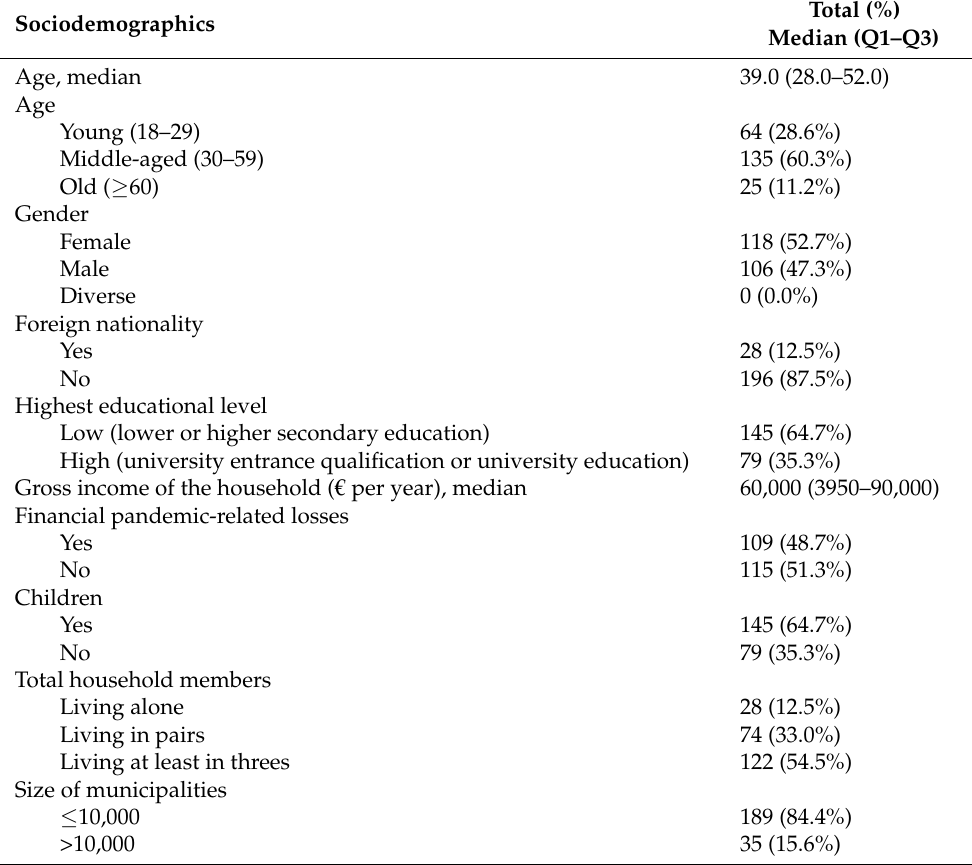
Table 2. Sample description ( n =